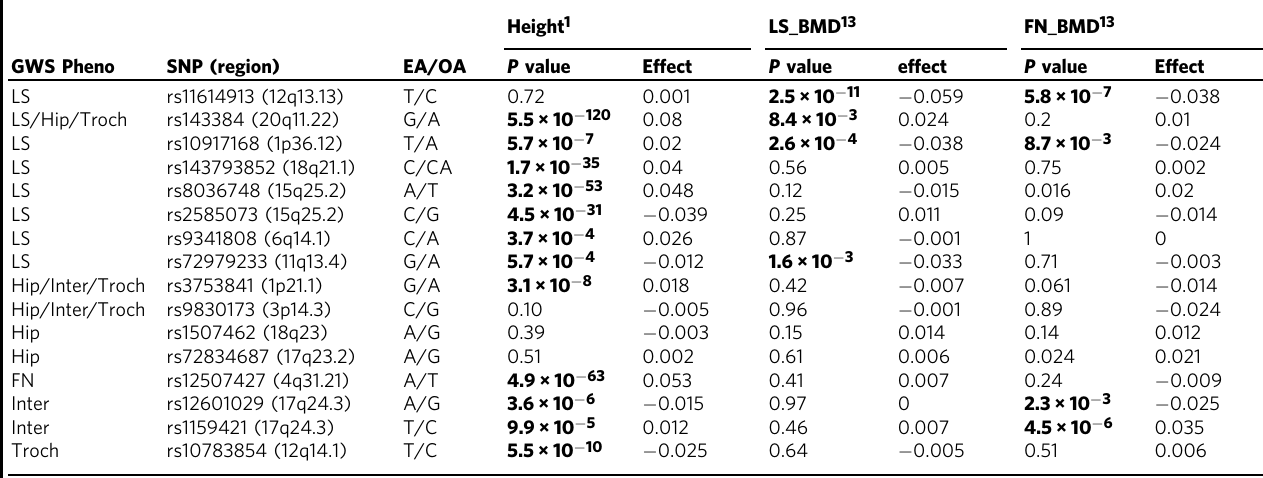
Table 3 Association of DXA bone area markers with height and